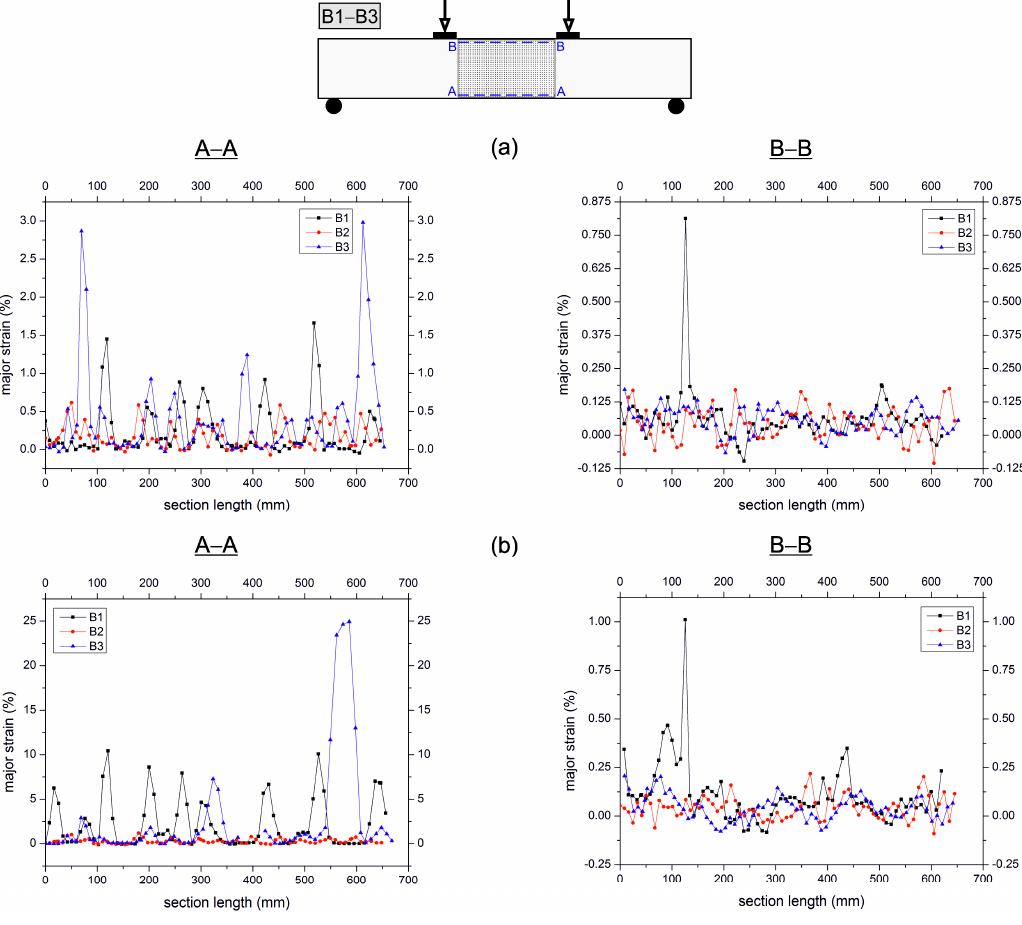
Figure 11. Major strains of concrete beam (B1) and hybrid fibre concrete beams (B2, B3): ( a ) at service load, and ( b ) at maximum load.